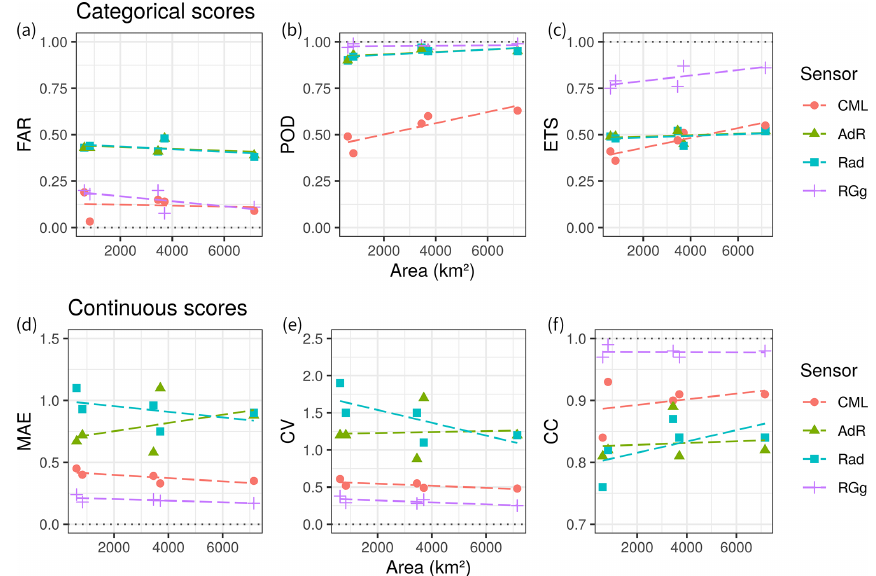
Figure 7. Scores of the areal-averaged rainfall amounts grouped per sensor and plotted against basin area. Linear fits are highlighted with dashed lines. The CML scores are also indicated numerically in Table 5.